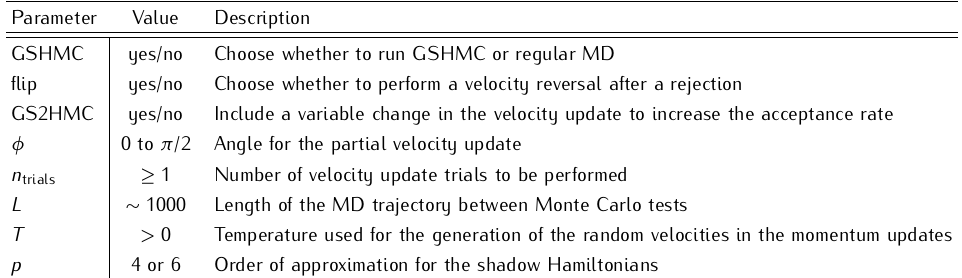
Table 1. Parameters used by the GSHMC